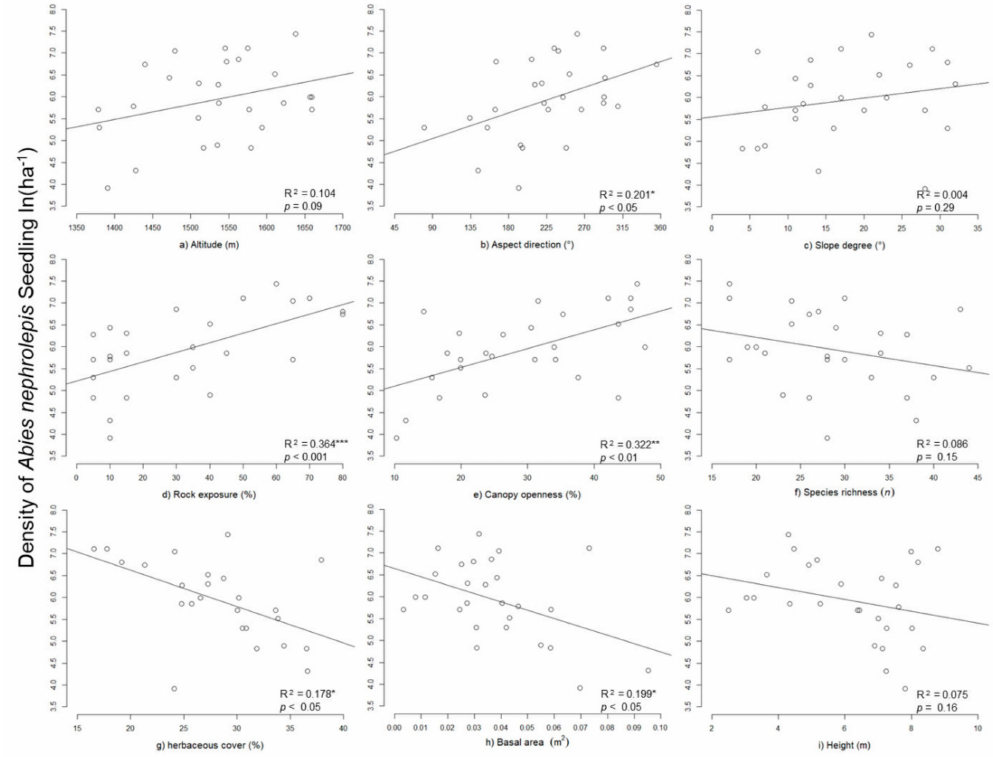
Figure 6. Relationships between seedlings and variables by simple linear regression analysis. Field data from 27 plots, investigated in Daecheongbong area in 2018, are represented by white points. (Note. Significance levels: * p < 0.05; ** p < 0.01; *** p <